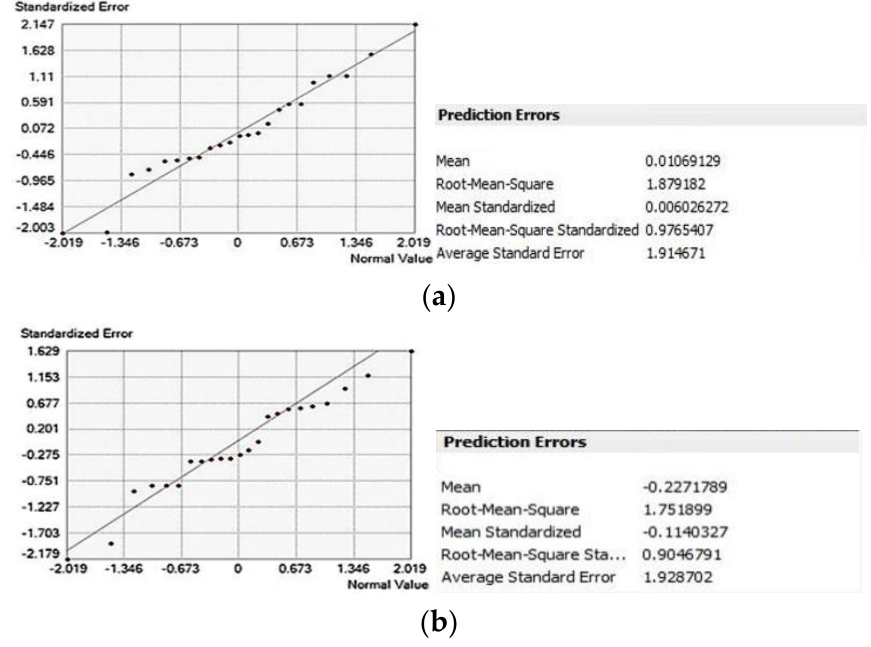
Figure 10. The subset of standardized error of QQ plot of the distribution of the dataset which is used for ( a ) kriging and ( b ) co-kriging models.